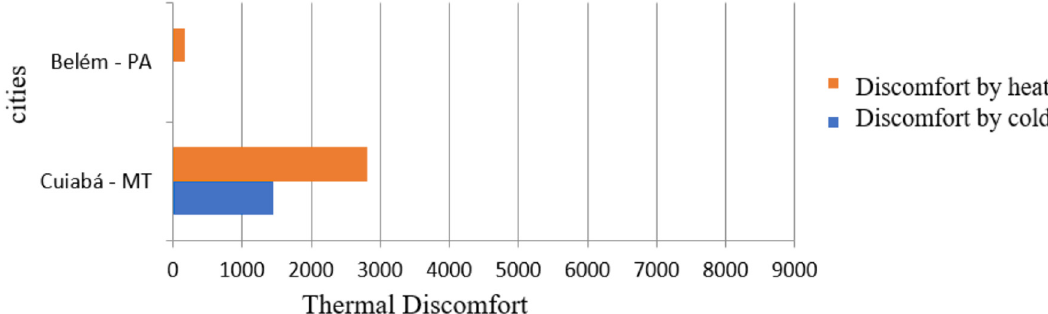
Fig. 7. Total discomfort in ° C h due to cold and heat for cities in Cuiabá